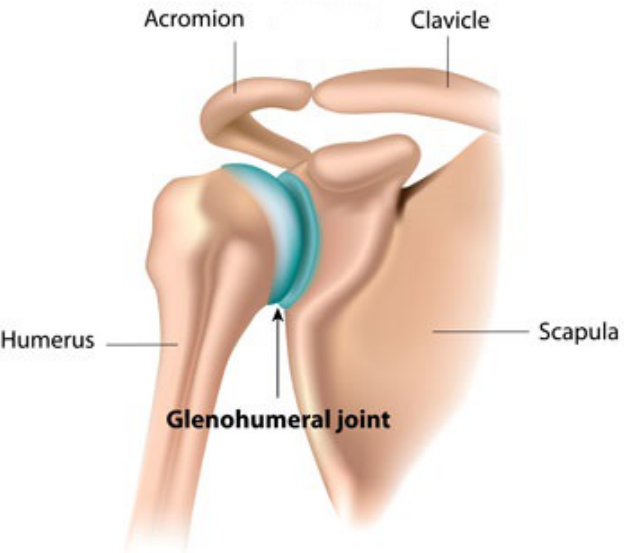
Figure 1. Anatomy of shoulder joint and shoulder